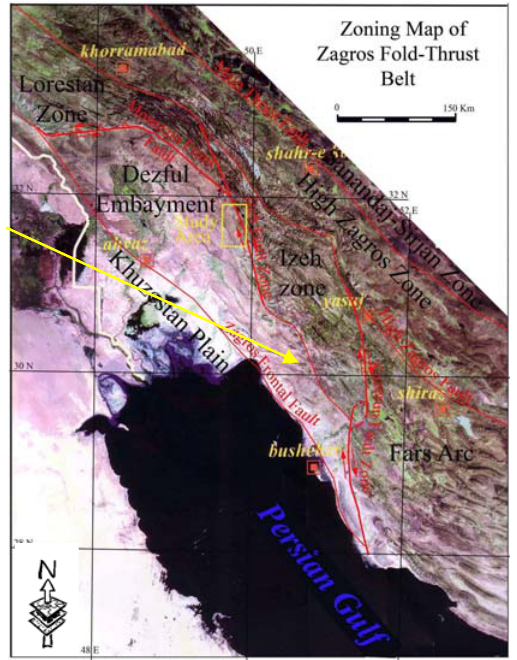
Figure 1. Structural zones of the Zagros fold-thrust belt and location of the study area together with a structural map of part of the Izeh fault